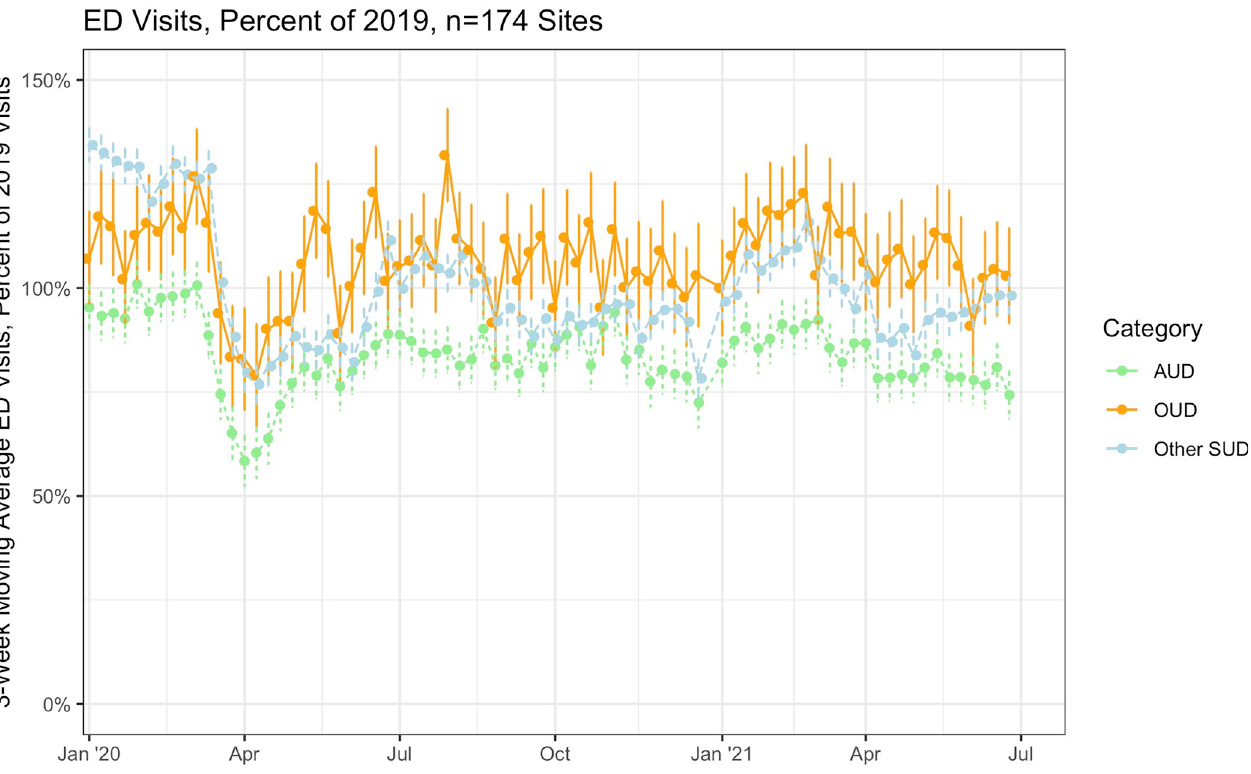
Fig 2. Trends in weekly ED visits for OUD, AUD, and other SUD-related, 2020. Notes: Figure depicts 3-week moving average ratio of emergency department visit counts in 2020 and 2021 compared to identical weeks in 2019. Sample includes 174 hospital-based EDs across 33 states from a national emergency department clinical quality registry. Visits for opioid use disorder (OUD), alcohol use disorder (AUD) and other substance use disorder (SUD)- related were identified by International Classification of Disease -10 codes.